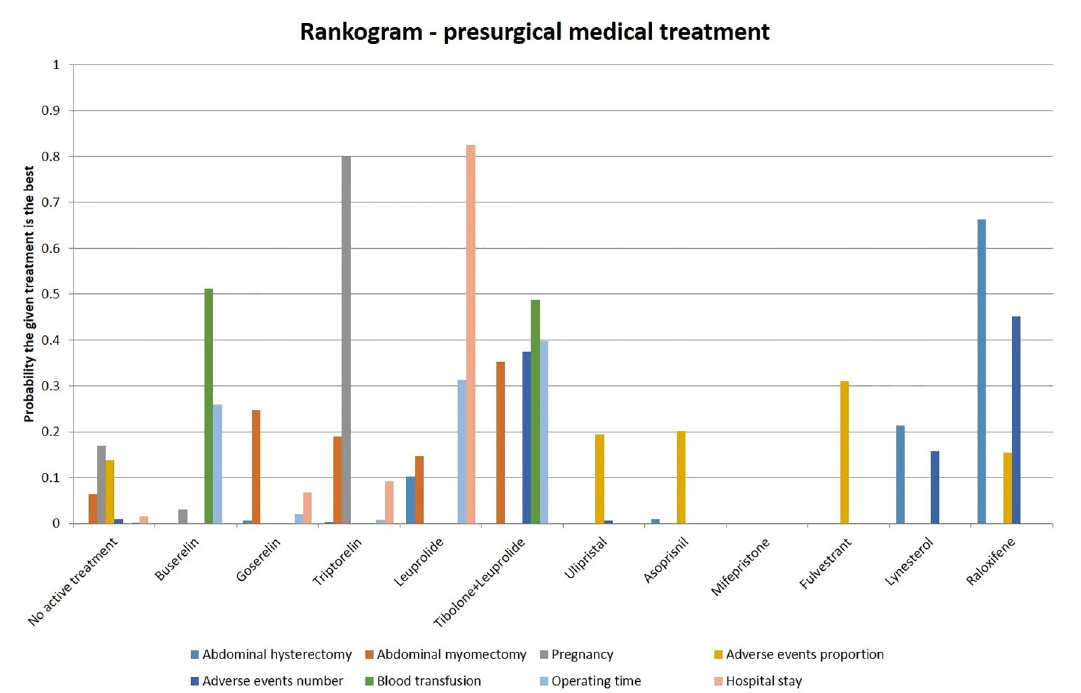
Fig 4. Different presurgical medical treatments —